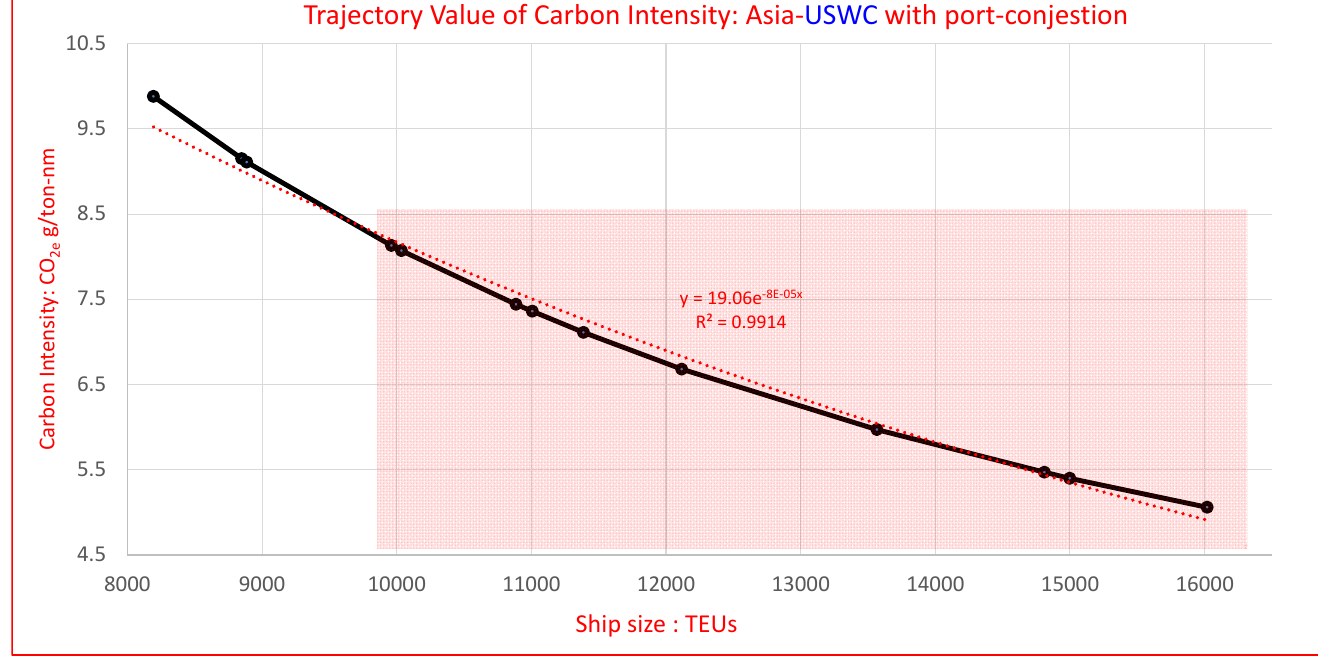
Figure 4. The Carbon Intensity against Ship Size of Route B-1.